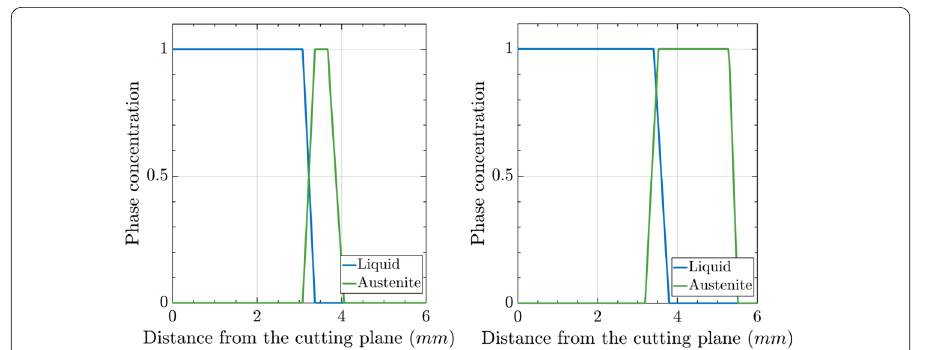
Figure 9 Liquid and austenite phases along line D. Left, with consideration of heat losses in the kerf, right without